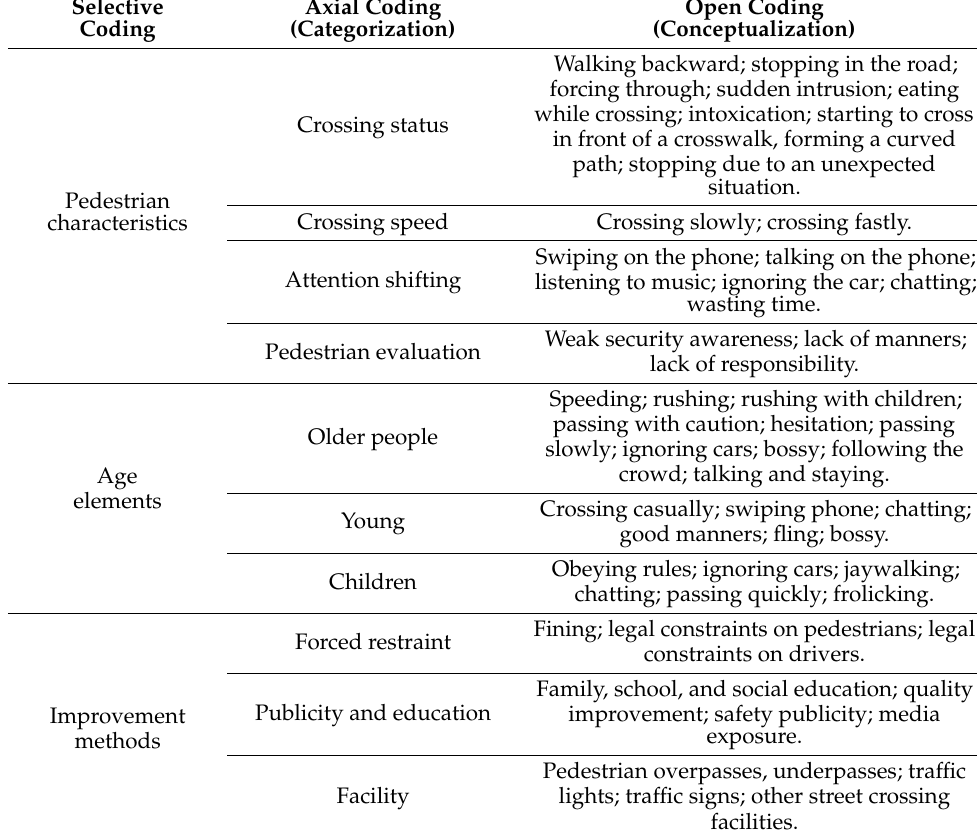
Table 3. The three-level coding process of interview